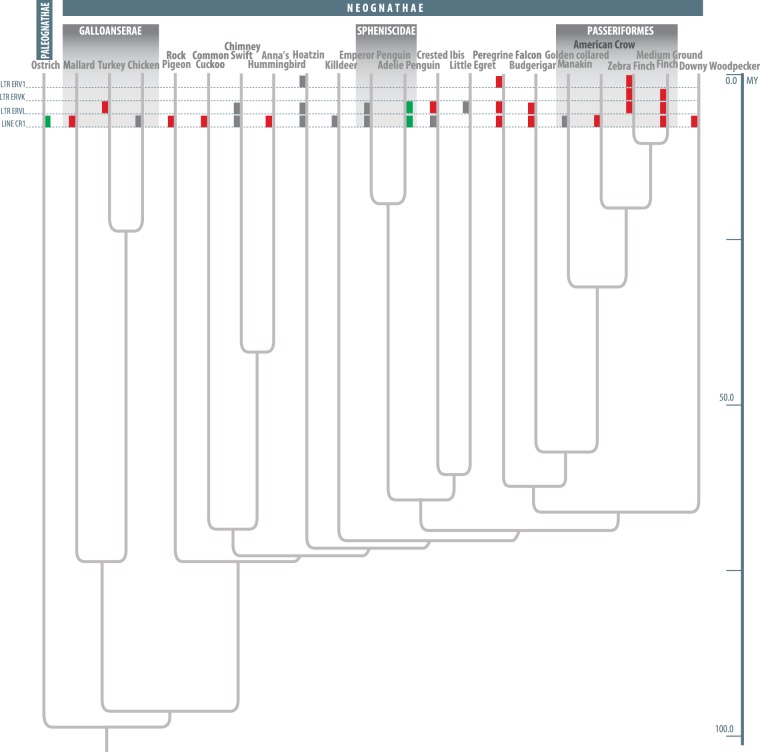
Relationship between lineage-specific EBRs and TEs in avian species. The phylogenetic tree is based on (Jarvis et al. 2014). Red bars indicate a significant enrichment of TEs from one or more abundant avian TE families (LINE-CR1, LTR-ERVL, LTR-ERVK, and LTR-ERV1) in lineage-specific EBRs (P value <0.05; FDR < 10%); green bars show significant negative associations of TEs with lineage-specific EBRs (P value <0.05; FDR < 10%); and grey bars indicate elevated numbers of the TE families in lineage EBRs (higher number of TEs in EBRs compared to the rest of the genome but not reaching a significance level of P value <0.05 and FDR < 10% likely due to a low number of lineage-specific EBRs resulting in low power of the statistical test).